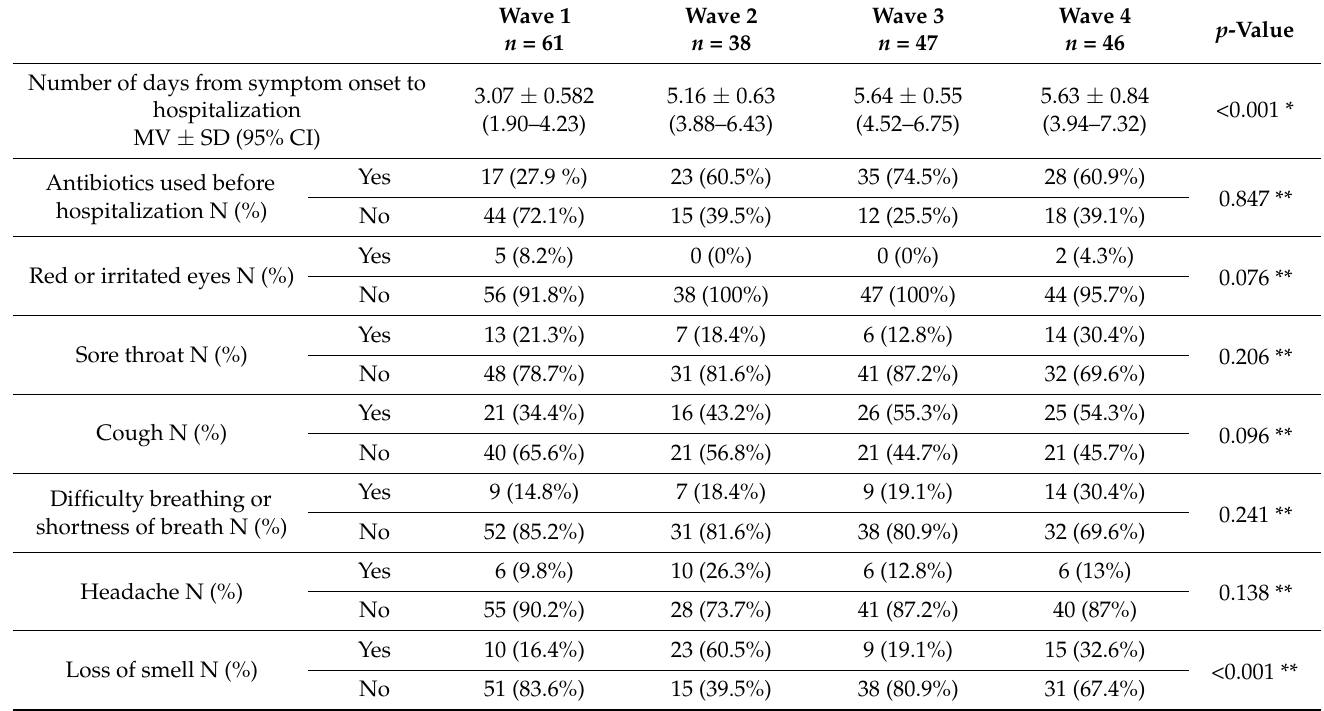
Table 3. Distribution of symptoms before hospitalization in pregnant COVID-19 patients with regard to pandemic